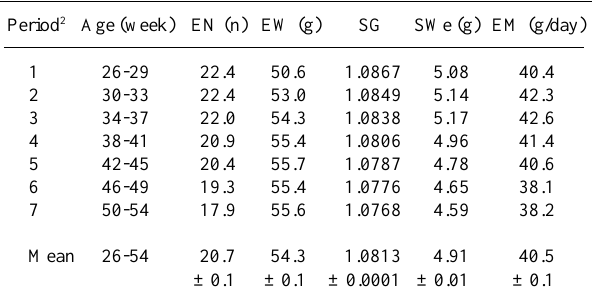
Table I Least squares means for egg traits in White Leghorn hens.